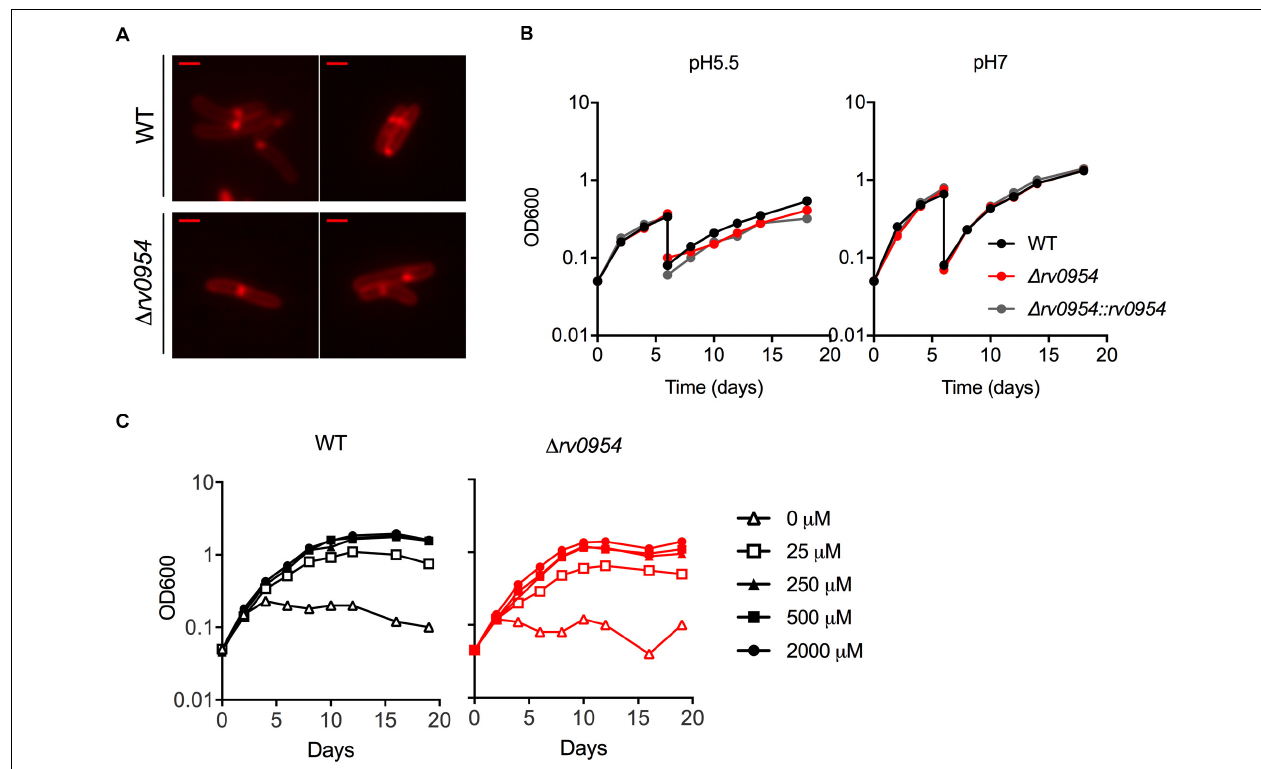
FIGURE 4 | Characterization of Mtb (cid:49) rv0954 . (A) Morphology of replicating WT and (cid:49) rv0954 cultured in 7H9 broth. The bacterial cells were collected and stained with FM5-95 before imaging. Scale bar, 1 µ m. (B) Growth curves of Mtb strains sequentially cultured in 7H9 medium adjusted to pH5.5 or pH7. The cultures were diluted in the same medium on day 6. (C) Growth curves of Mtb incubated in chelated Sauton’s medium supplemented with Mg 2 + at the indicated